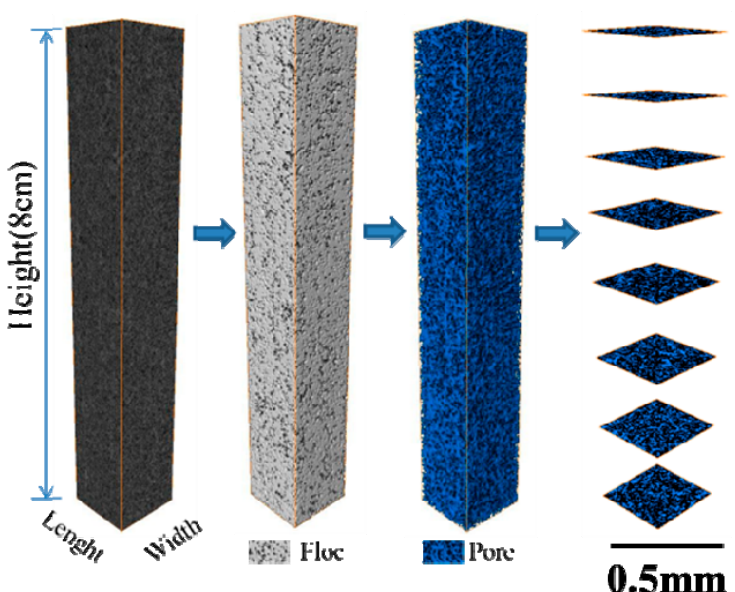
Figure 12. Variation pattern of pore structure extraction versus bed height.